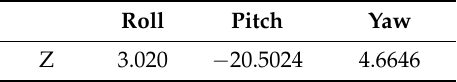
Table 4. The value of Z in roll, pitch and yaw.